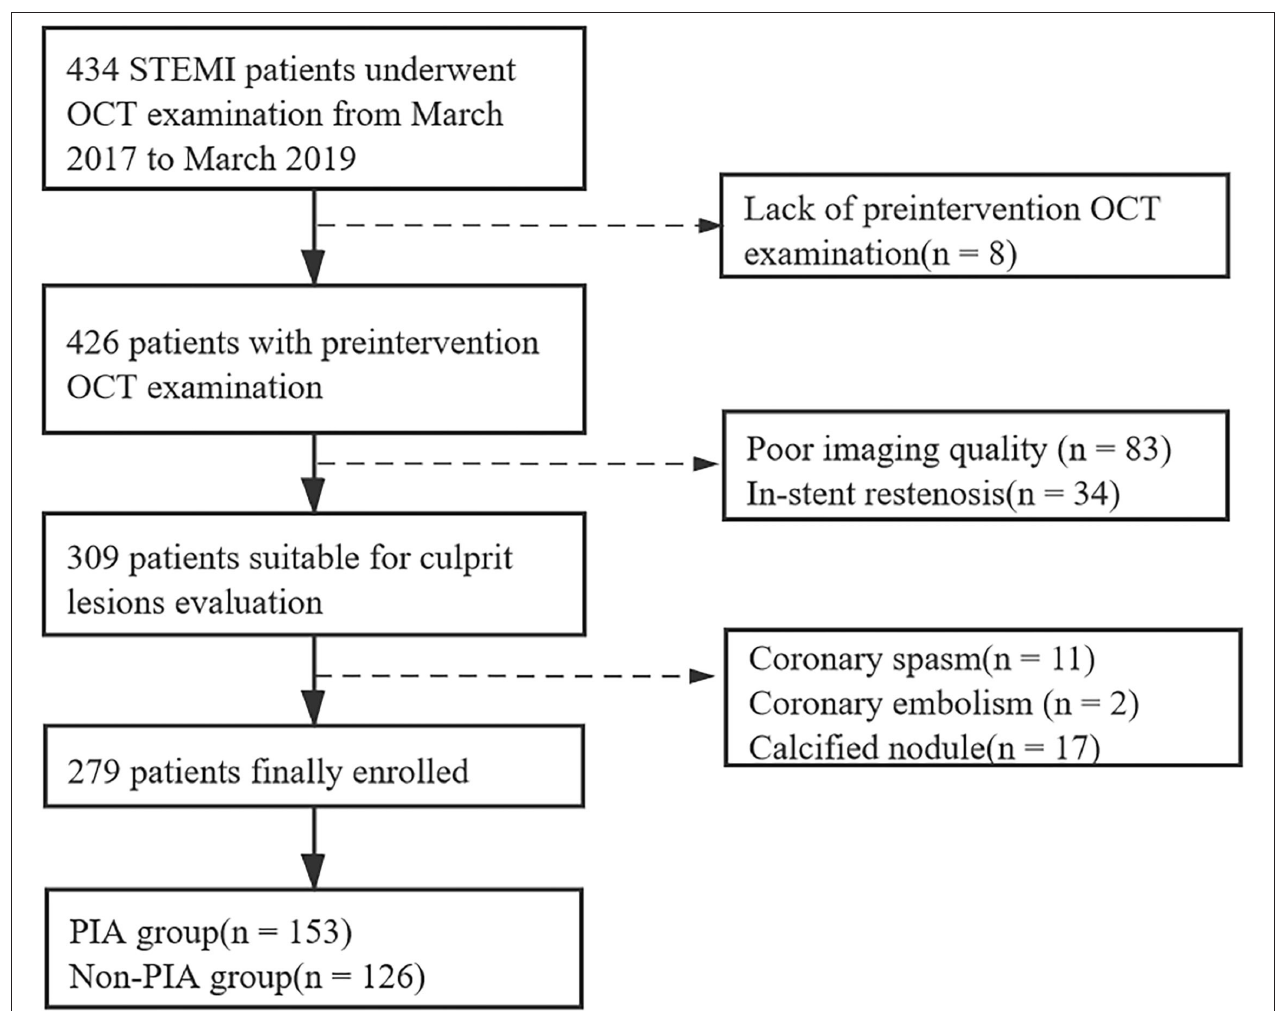
FIGURE 2 | Study flowchart. STEMI, ST-segment elevation myocardial infarction; OCT, optical coherence tomography; PIA, preinfarction angina.